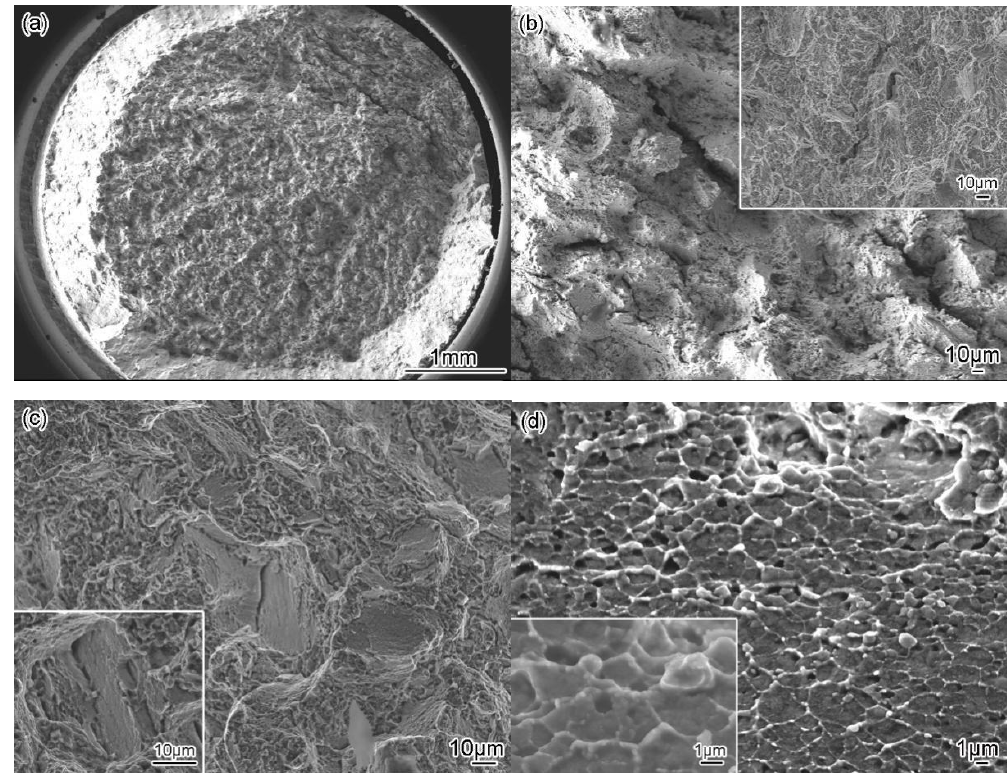
Figure 5. Fracture morphology of HIPed alloy after creep at 705 °C/897 MPa: ( a ) low magnification morphology, ( b ) fracture source region, ( c ) propagation region, ( d ) shear lip region.